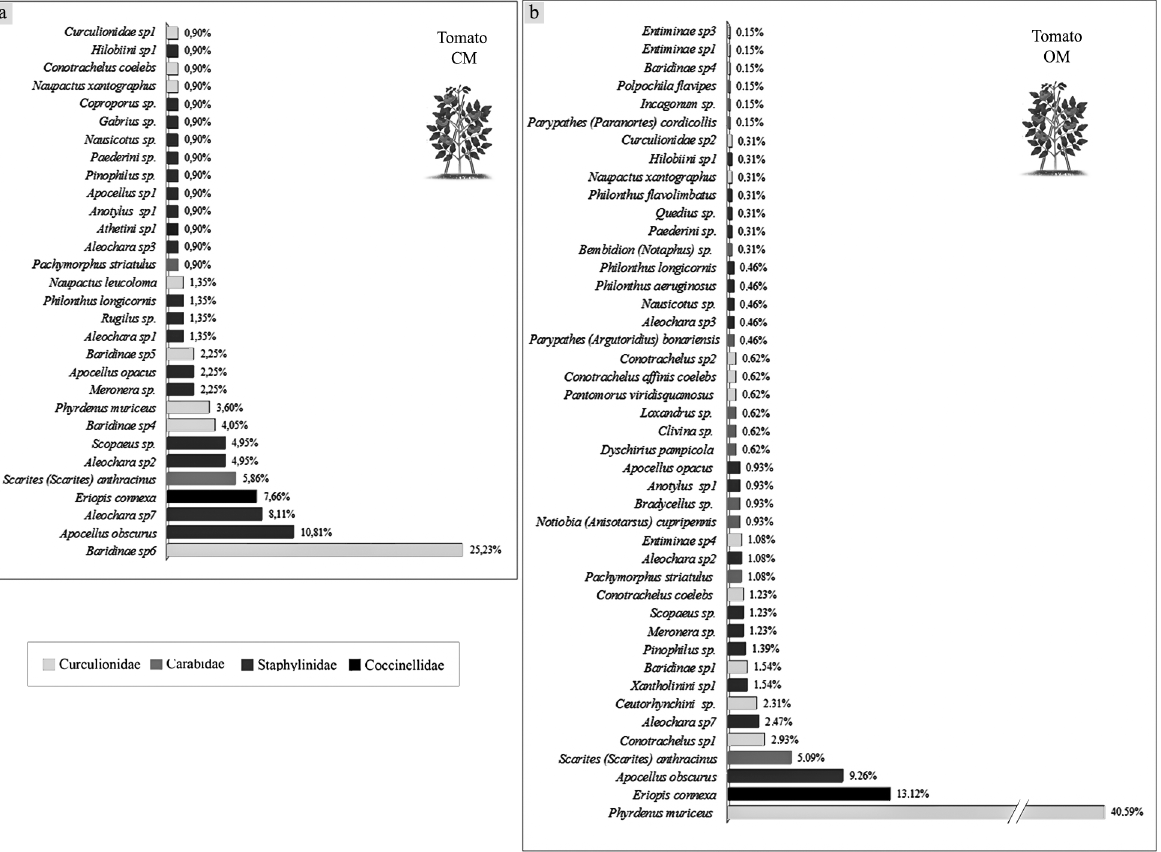
Figure 2. Relative abundance and dominance structure of Curculionidae, Carabidae, Staphylinidae and Coccinellidae species, collected in conventionally (CM), and organic (OM) managed tomato crops, during different cropping seasons: (a) Fall-winter, CM; (b) Fall-winter, OM; (c) Spring-summer, CM, and (d) Spring-summer, OM. Dominance categories (from Pedraza et al. 2010): highly dominant: > 5%, co-dominant: 4.9 - 2%, and rare: 0 -